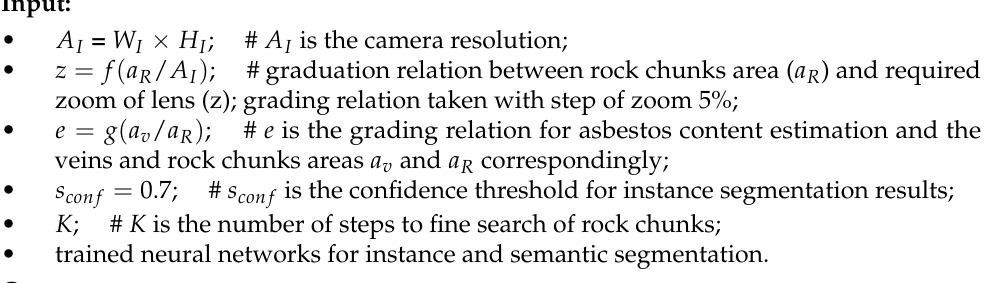
Algorithm 1 General algorithm of the system